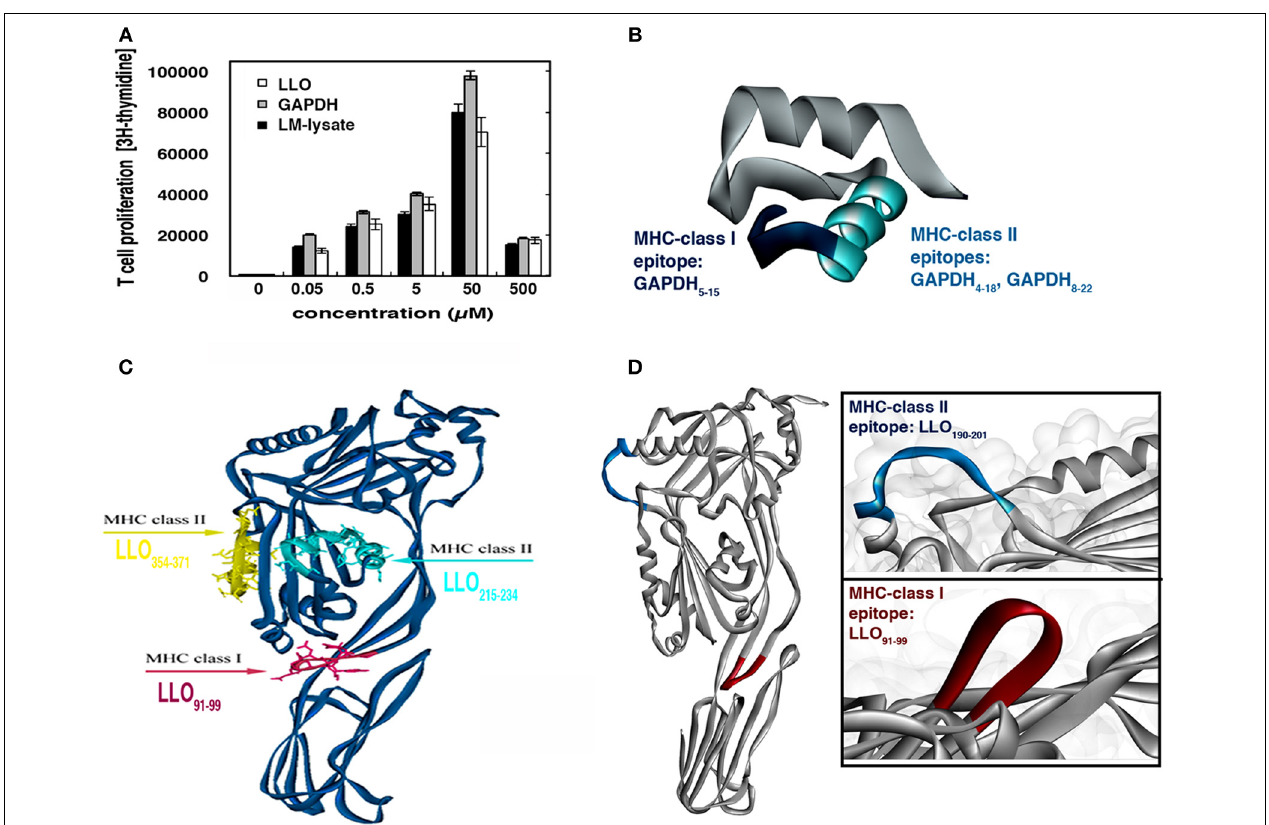
FIGURE 2 | Selection of L. monocytogenes antigens to evaluate primary T cell responses after vaccination with BMDMs and DCs. (A) Thirty micrograms of total membranes of BMDMs or DCs infected with L. monocytogenes was immunoprecipitated with mouse anti-MHC-II, and subjected to western blotting with rabbit anti-LLO (upper lanes) or rabbit anti-GAPDH 1 − 22 (lower lanes). NI lanes correspond to non-infected BMDMs or DCs. (B) T cell proliferation of